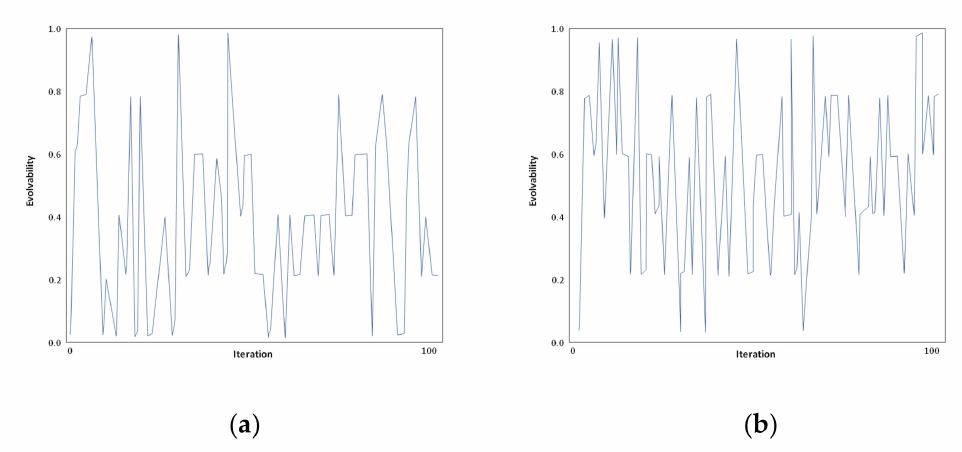
Figure 19. The evolvability along the iterations in case of cycle crossover ( a ) and partially matched crossover operator ( b ).